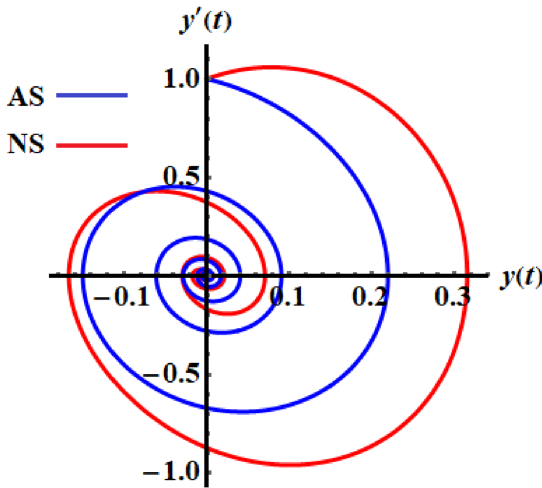
Figure 4. Shows the phase plane diagrams of the curves of Fig. 3.